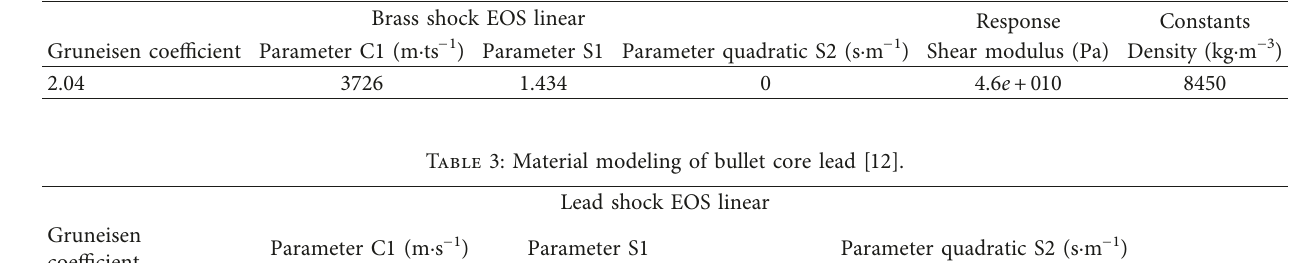
Figure 3: The representation in Ansys of the geometry and 3D mesh of the bullet. Table 2: Material modeling of bullet jacket brass [11].